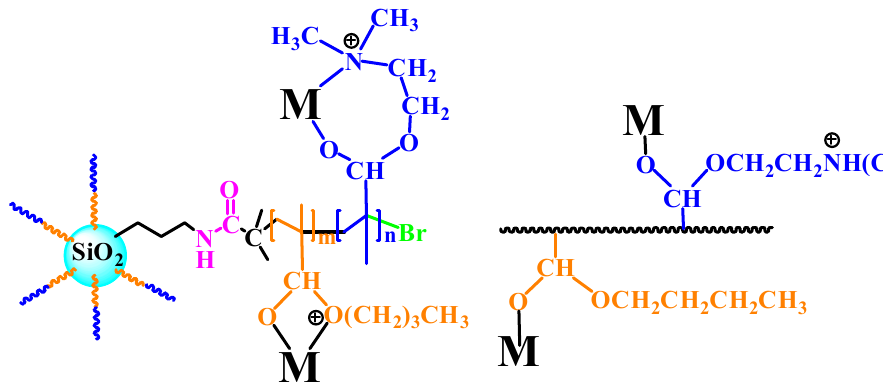
Figure 7. The proposed mechanisms for metal cation (M) adsorption.